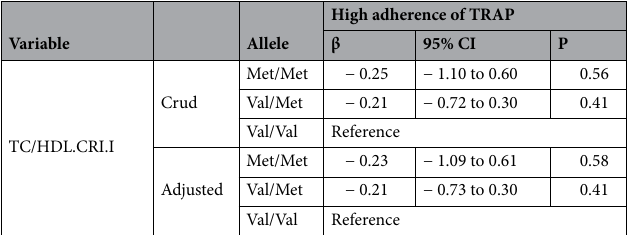
Table 7. The interaction of BDNF Val/Met polymorphism and TRAP on anthropometric indices, lipid profile and atherogenic indices. Val/Val genotype is considered as a reference. Low adherence of DTAC is considered as a reference. Generalized linear model; crude model and adjusted model Age, physical activity, sex, smoking, alcohol, energy intake, lipid, and glucose-lowering medicines, and family history of diabetes, as covariates. Bold values denote statistical signifcance at the P < 0.05 level. TRAP total reactive antioxidant potential, CI confidence interval, AIP (Atherogenic index of plasma): log(TG/HDL), AC (Atherogenic coefficient): (TC-HDL/HDL), CRI-II (Castelli s risk index): LDL/HDL, CRI-I (Castelli s risk index): TC/HDL, TC total cholesterol, TG triglyceride, HDL high density lipoprotein, LDL low density lipoprotein, WC waist circumference.